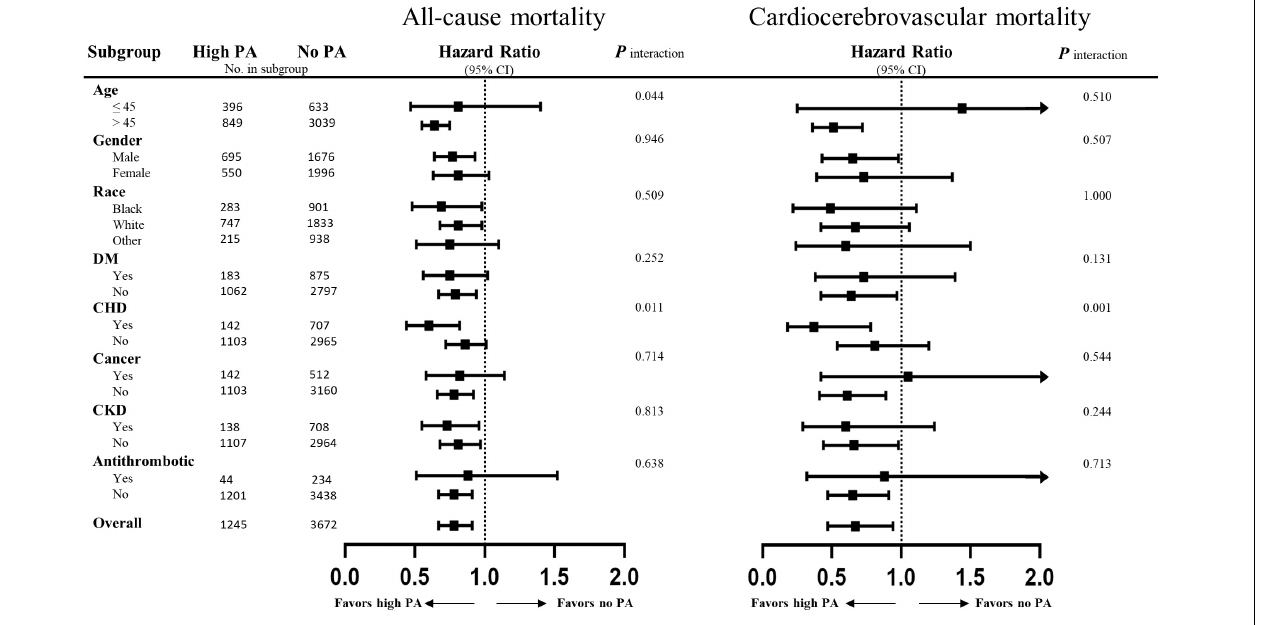
FIGURE 3 | Subgroup analyses of the association between physical activity and the adverse outcomes. Risks of all-cause and cardiocerebrovascular mortality of the high physical activity defined by equals to or greater than 7.5 MET-h/week as compared to physically inactive cohorts. Results are expressed as multivariable-adjusted hazard ratio after controlling covariates that include age, gender, race, body mass index, education, smoking, diabetes, coronary heart disease, chronic heart failure, stroke, cancer, systolic blood pressure, diastolic blood pressure, heart rate, total cholesterol, triglyceride, low-density lipoprotein cholesterol, estimated glomerular filtration rate (eGFR), cholesterol intake, total fat intake, energy intake, protein intake, sodium intake, and medications (antiplatelet, warfarin, statin, antihypertensive drugs, β -blockers, α -blockers, diuretics, and hypoglycaemic agents), where possible interactions between above factors are also adjusted if